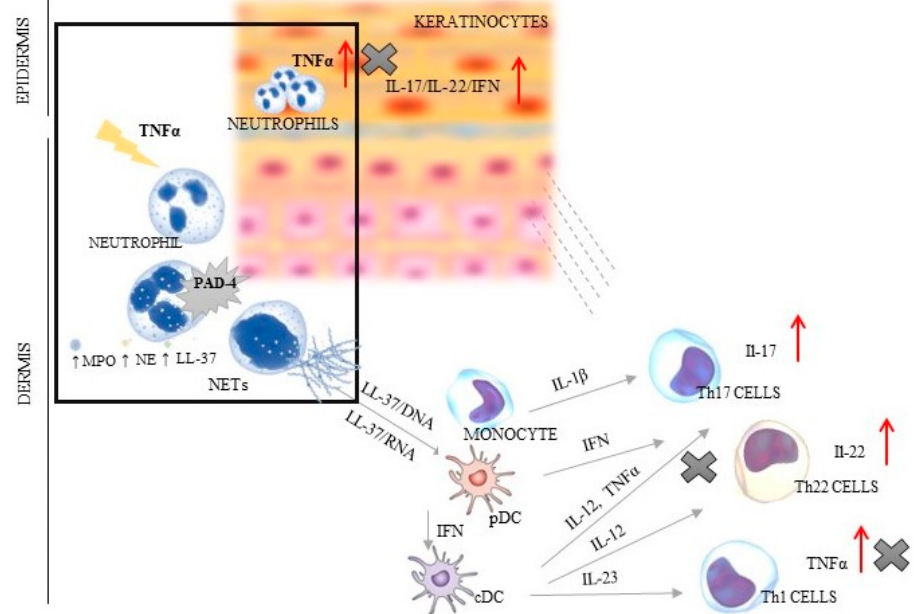
Figure 1. The dependence between NET creation and TNF/IL-23/IL-17 axis in psoriatic skin (the box shows the relation of TNF α and PAD-4; ↑ indicates an increase in the secretion of presented fac- tors; X indicates the sites of inhibition of TNF α production by using of anti-TNF therapy). PAD-4— peptidyl arginine deiminase 4; NE—neutrophil elastase; MPO—myeloperoxidase; cDC—conven- tional dendritic cell; IFN—interferon; IL—interleukin; LL37—cathelicidin; NETs—neutrophil extra- cellular traps; pDC—plasmacytoid dendritic cells; Th—T helper lymphocyte; TNF—tumor necrosis factor.